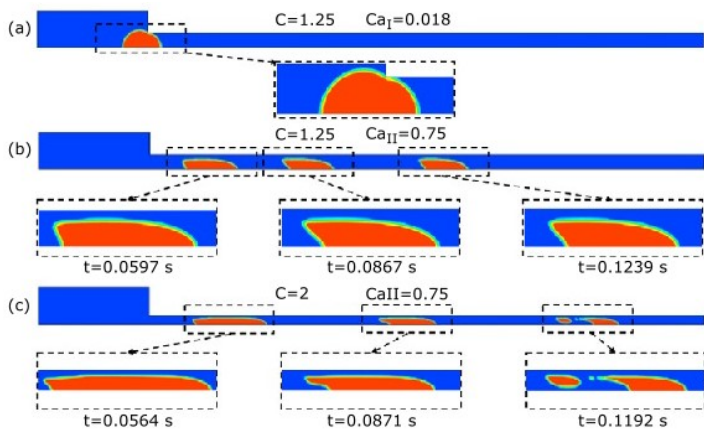
Figure 7. Droplet cross-section at the symmetric plane viewed from trop: ( a ) trap regime; ( b ) squeeze regime; and ( c ) breakup regime. C is a non-dimensional number representing the contraction level (C = D / W , where D is the droplet diameter, and W the contraction microchannel width). In the thicker part of the microchannel (i.e., before the contraction), the inlet velocity is employed as the characteristic velocity, and the Capillary number is denoted as Ca I , while the average velocity in the thinner region of the microchannel (i.e., after the contraction) is used to define the Capillary number Ca II . Adapted with permission from